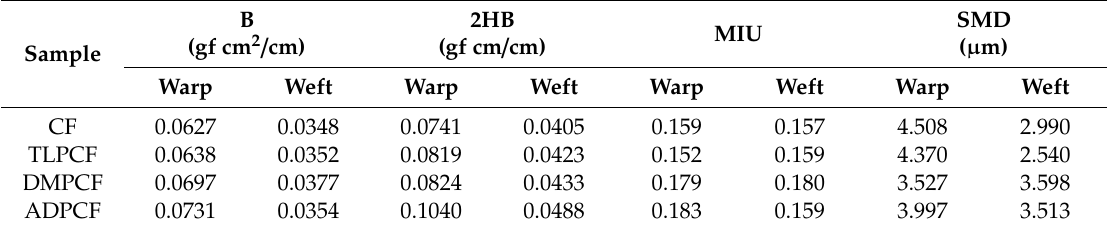
Table 4. Bending properties and surface friction properties of control and modified cotton